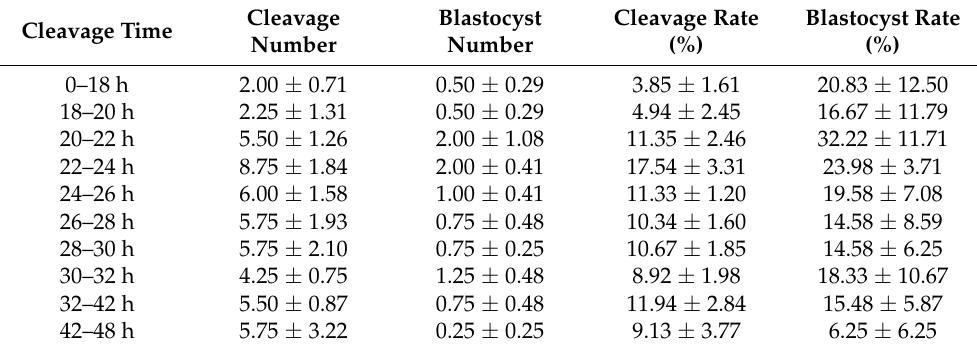
Table 3. Statistics of cleavage time for IVF